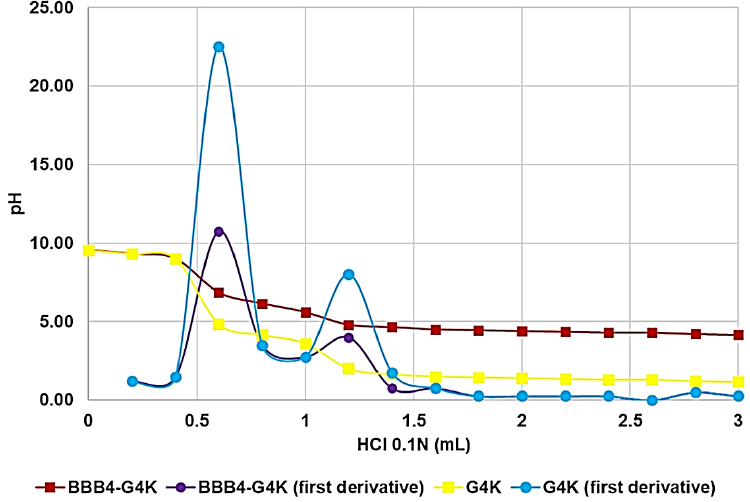
Figure 14. Titration curves (error bars not reported since they are difficult to detect) and first derivative lines of the titration curves of G4K and BBB4-G4K.